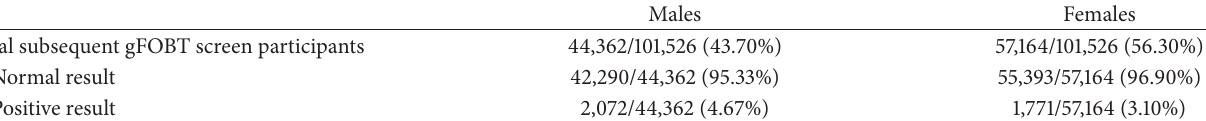
Table 2: Subsequent gFOBT screen 21–30 months after baseline normal gFOBT result.